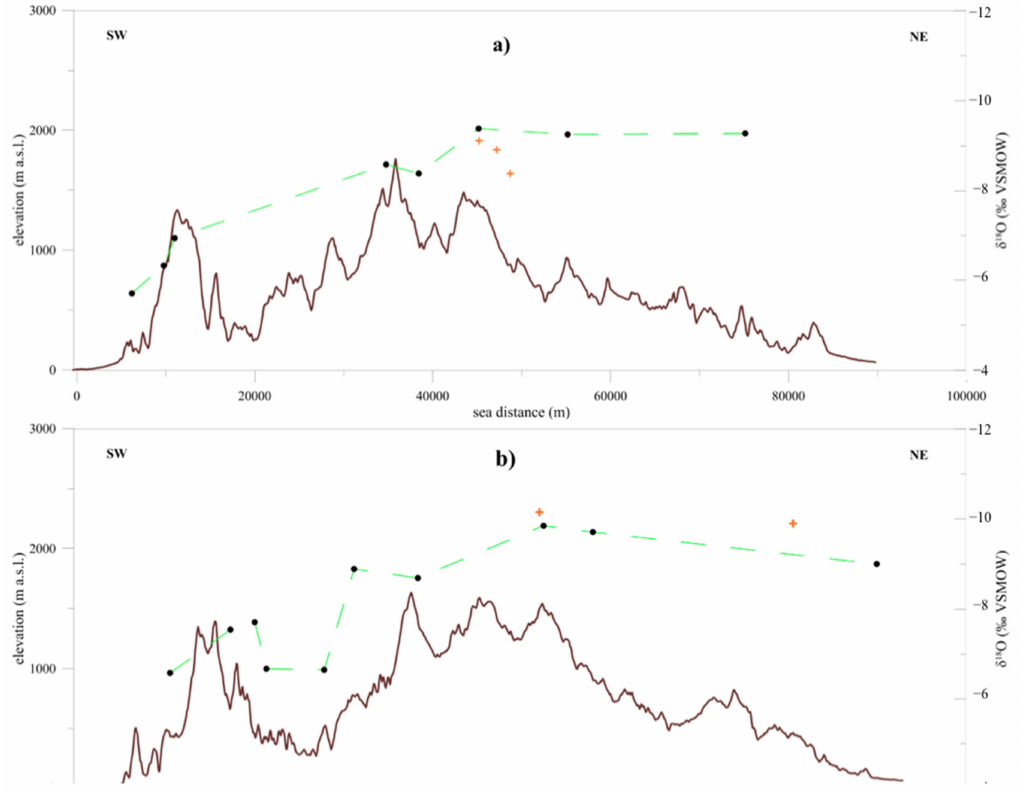
Figure 4. Altitudinal and isotopic profiles concerning the southern ( b ) and northern ( a ) transects (trace sections are reported in Figure 2): the dashed line is the isotopic profile; the solid line is the topographic profile. Orange crosses represent the isotopic values of springs not included in the transects (see Figure 2). The y-scale is exaggerated by